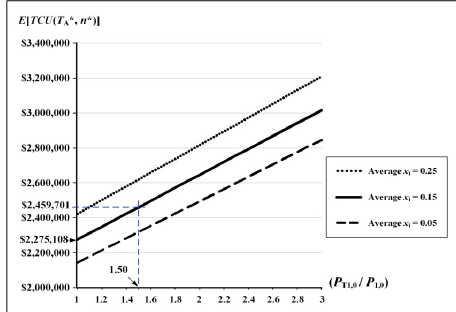
Fig. 13. The collective effect of ( P T1,0 / P 1,0 ) and various mean x i on E [ TCU ( T A *, n *)]